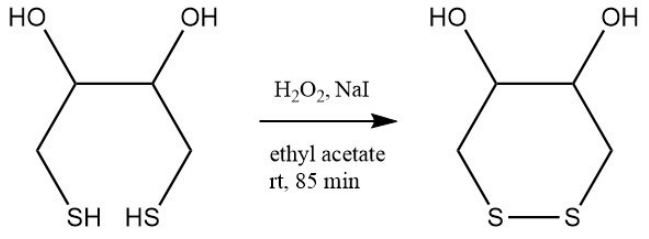
Figure 3. Oxidation of dithiothreitol. In an oven-dried flask, N-Benzyltrimethylammonium hydroxide (40% w / w in meth- anol, 300 µL, 276 mg, 1.65 mmol) was concentrated under vacuum and cooled to room temperature. Ox-DTT (100 mg, 0.65 mmol) in acetonitrile (10 mL) was added to this solu-